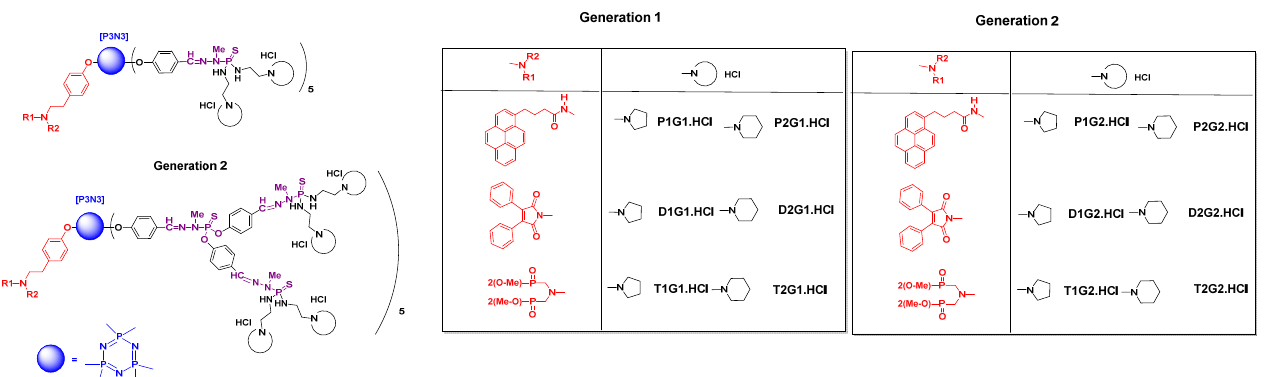
Figure 7. Chemical structures of polycationic phosphorus dendrons.